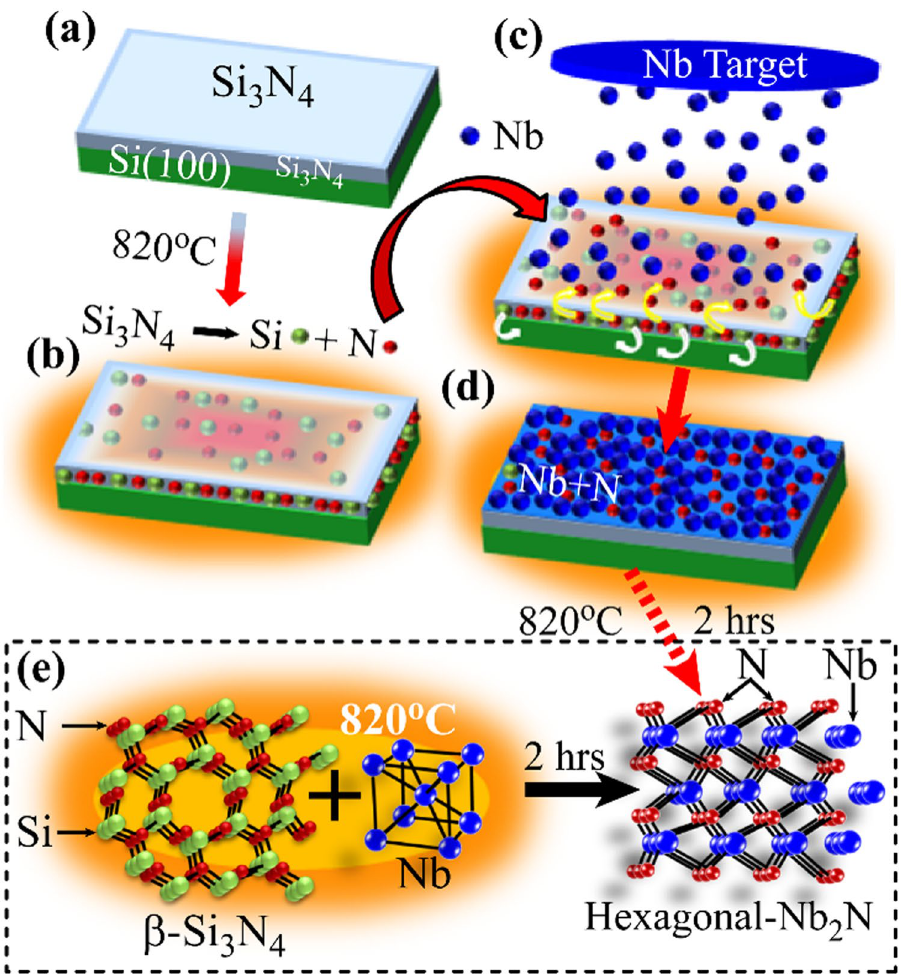
Figure 1. ( a – d ) Schematic presentation of the nitridation process for the transformation of Nb to Nb 2 N by using high temperature annealing with Si 3 N 4 /Si substrate. Arrows indicate the step wise process protocol. ( e ) Chemical representation of the reaction between Nb and Si 3 N 4 under high temperature annealing leading to the formation of Nb 2